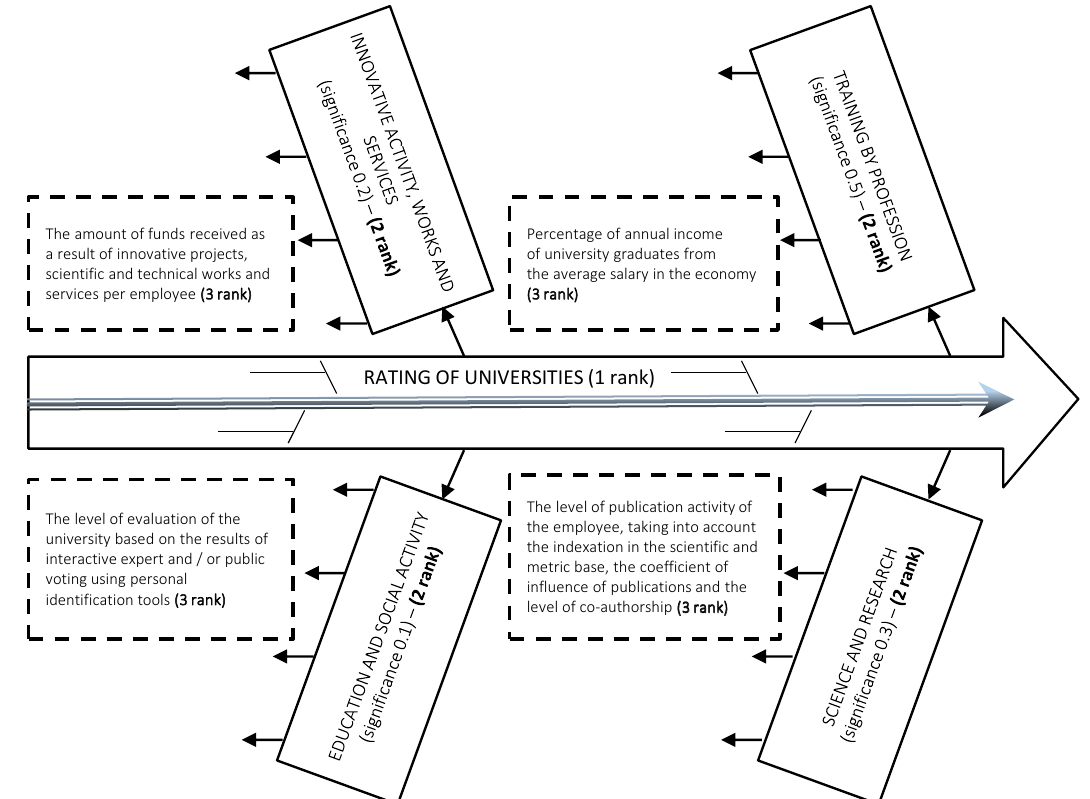
Figure 3. Ishikawa diagram with essential indicators of national rating in the higher education system of